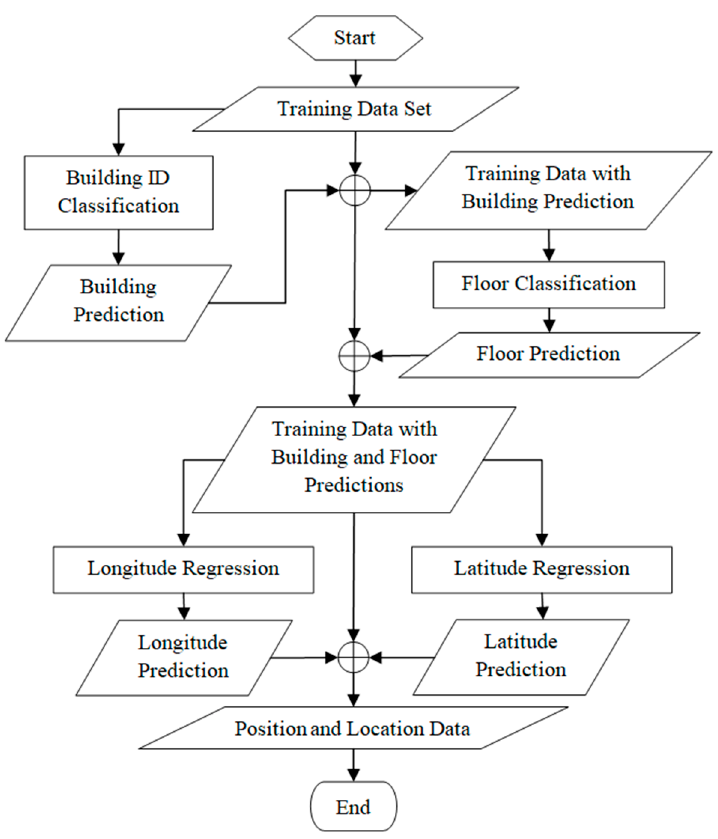
Figure 1. Positioning and localization diagram.